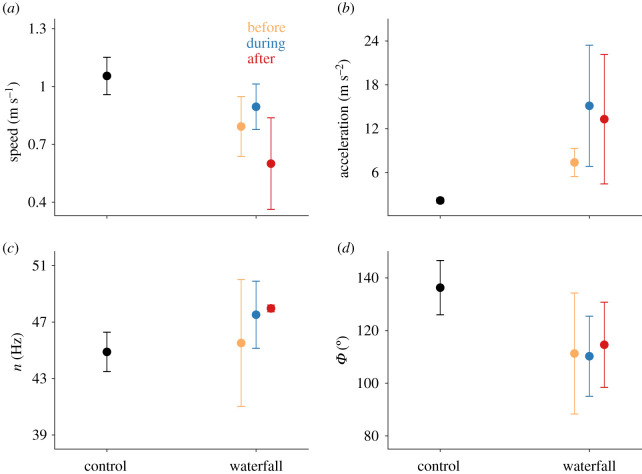
(a) Speed, (b) acceleration, (c) stroke frequency and (d) stroke amplitude for four hummingbirds flying in still air (black), and before (orange), during (blue), and after (red) crossing the waterfall. Data points represent means ± one standard deviation; see electronic supplementary material, table S2 for statistical results.